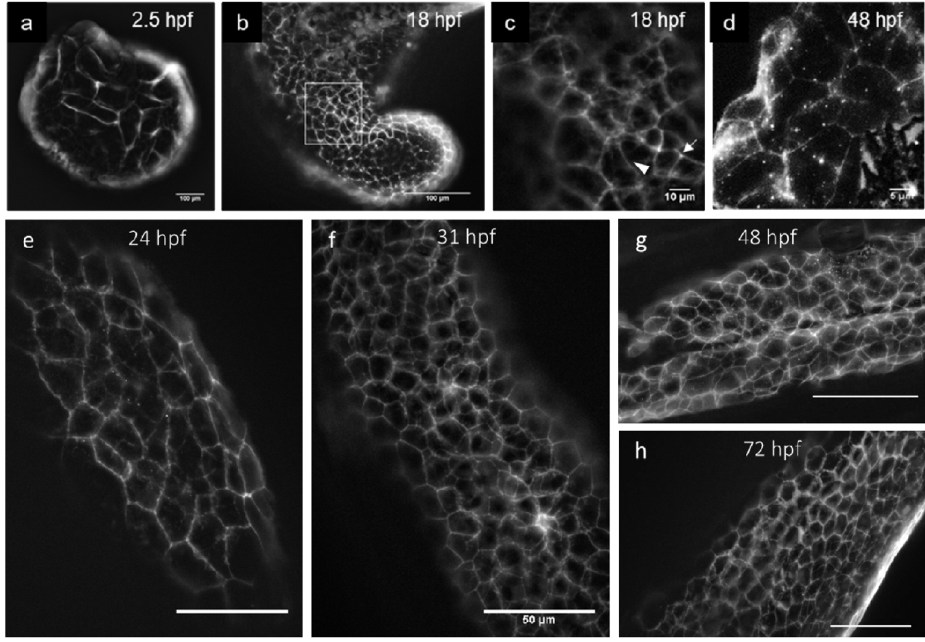
Figure 1. E-cadh immunofluorescence detection in zebrafish embryo epidermis. a ) at 2.5 hours post fertilization (hpf) b ) at 18 hpf; c ) Zoom of selection in b ) showing a single puncta adherens in contacting EVL cells (arrow) and weak E-cadh detection in the EBL (arrowhead); d , g ) at 48 hpf, showing cytoplasmic dot labeling in EVL cells ; e – h ) 24 to 72 hpf embryos, displaying E-cadh distribution in trunk, clearly visible in underlying EBL cells from 24 hpf. Images are contrast enhanced maximum intensity projections of 20 optical slices, z-step: 0.33 µm, scale bar: 50 µm. Objective: UPLFLN 40X 1.3 NA